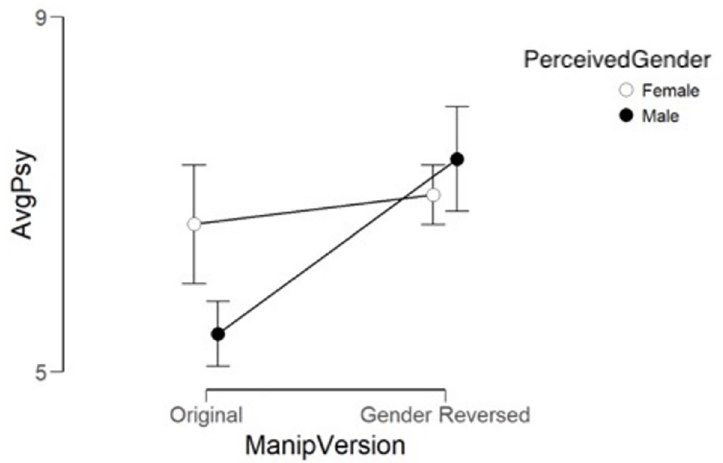
Fig 6. Comparison of ratings of original narratives and gender-reversed narratives by perceived gender and psychological violence. Hollow circles stand for female and filled circles for male gender, original ratings are on the left side and gender reversed on the right. Bars show 95% confidence interval.